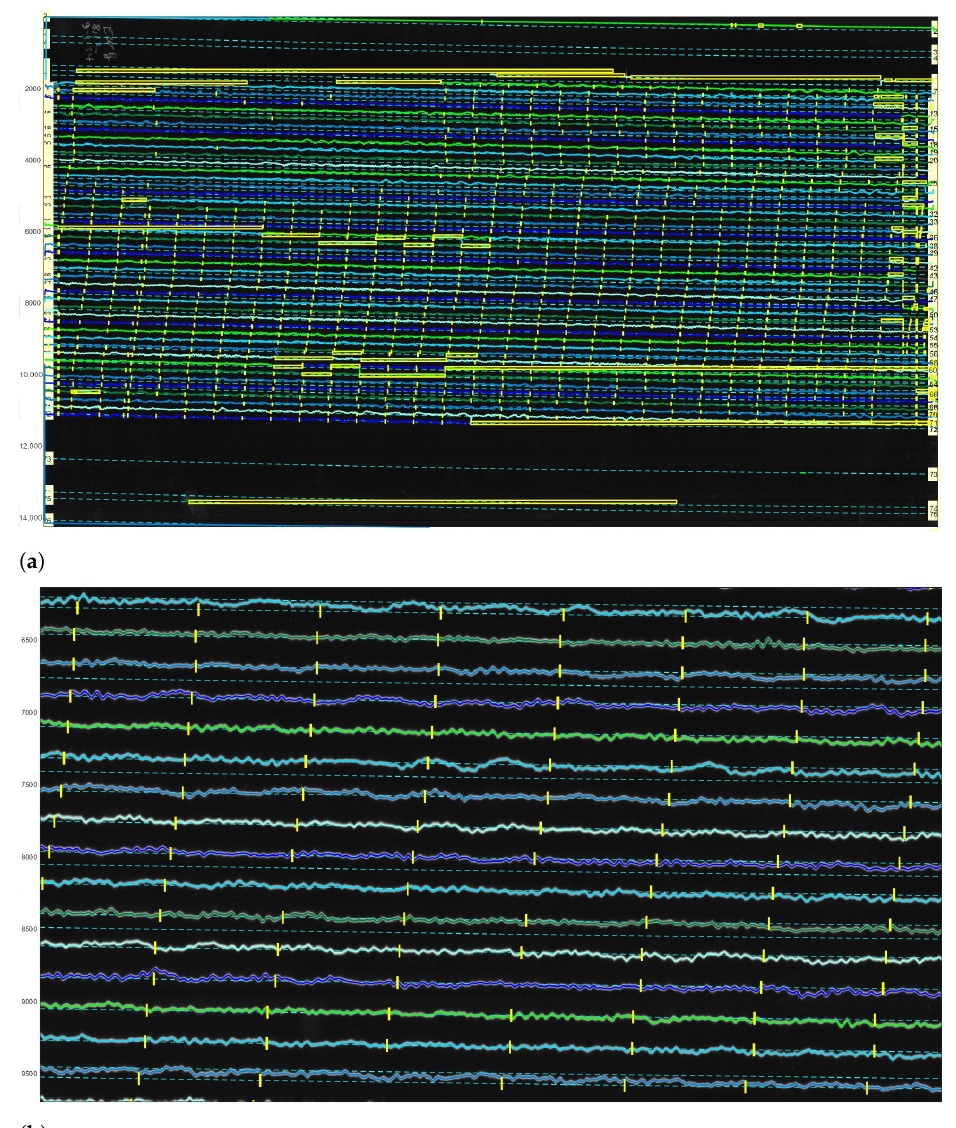
Figure 12. Results of the paper-based seismogram vectorisation processed by DigitSeis. ( a ) Digitised traces upon completion of the automated vectorisation. Some time gaps in the upper left part of the image were too small and not clearly visible for the automatic discrimination between the trace and the dark background. In these cases, gaps required manual correction to identify time intervals. ( b ) The enlarged view of the automatically recognised digitised traces displayed by the lines of various colours, zero-lines for each trace (cyan, dashed lines, numbered from top to bottom) and time gaps (vertical yellow